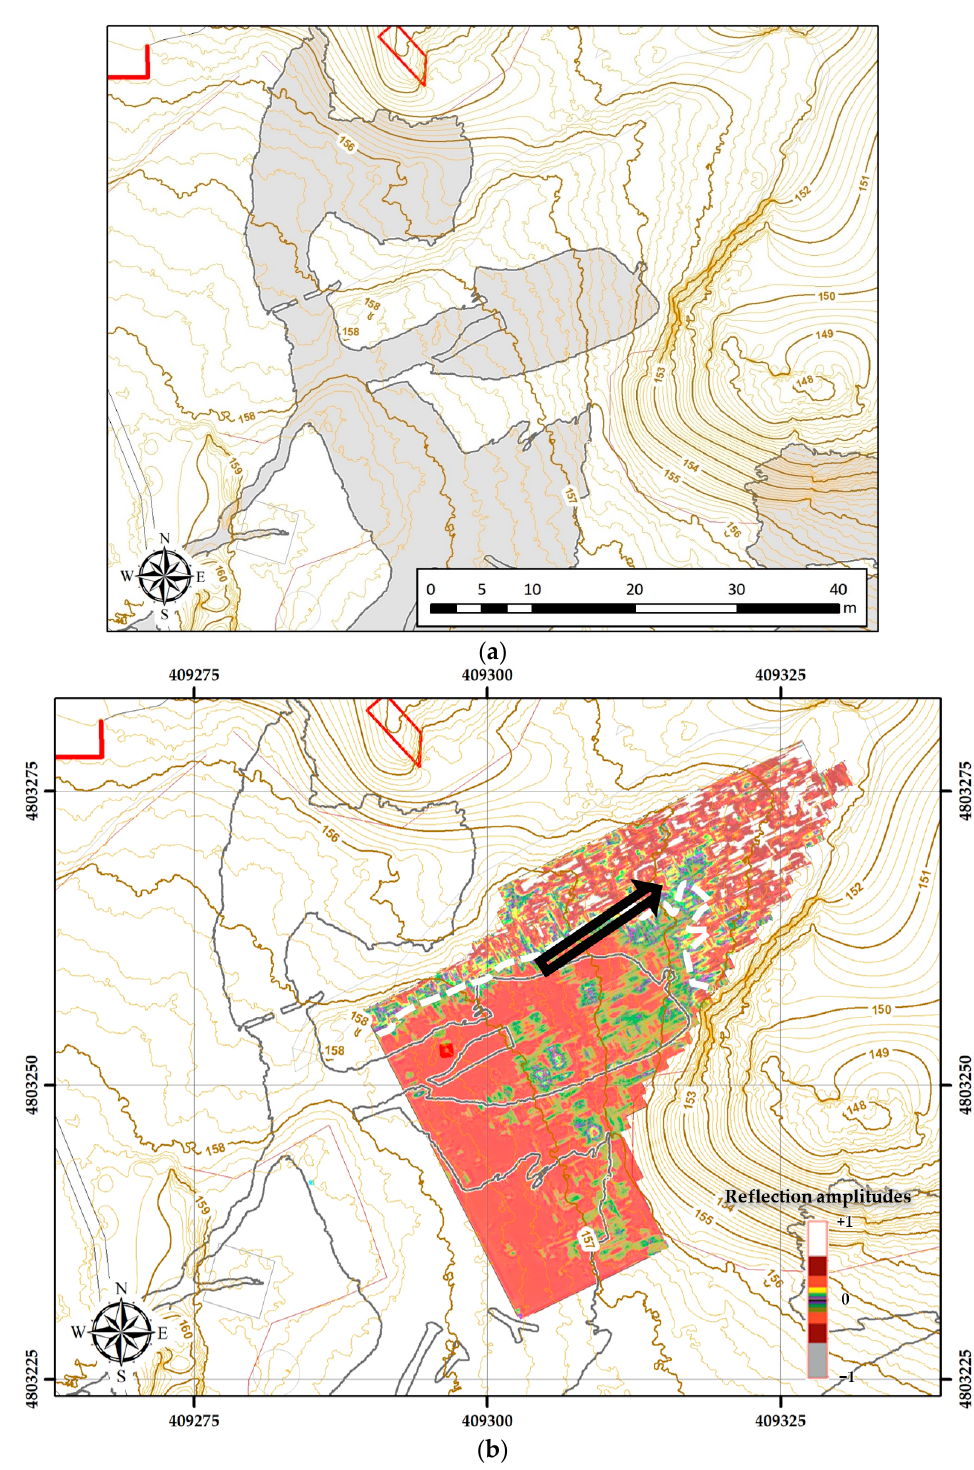
Figure 16. Projection of the Polychrome Hall on the topographic map, showing a change of orientation and slope (indicated with black arrow) that tilts to the NE ( a ), and which also corresponds to the projection of the second level of discontinuities in its amplitude depth slice (2.20 m depth) ( b ).